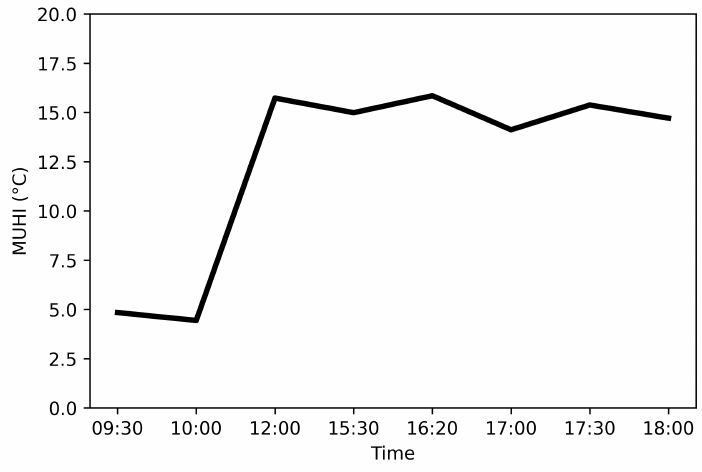
Figure 6. Temporal variation of